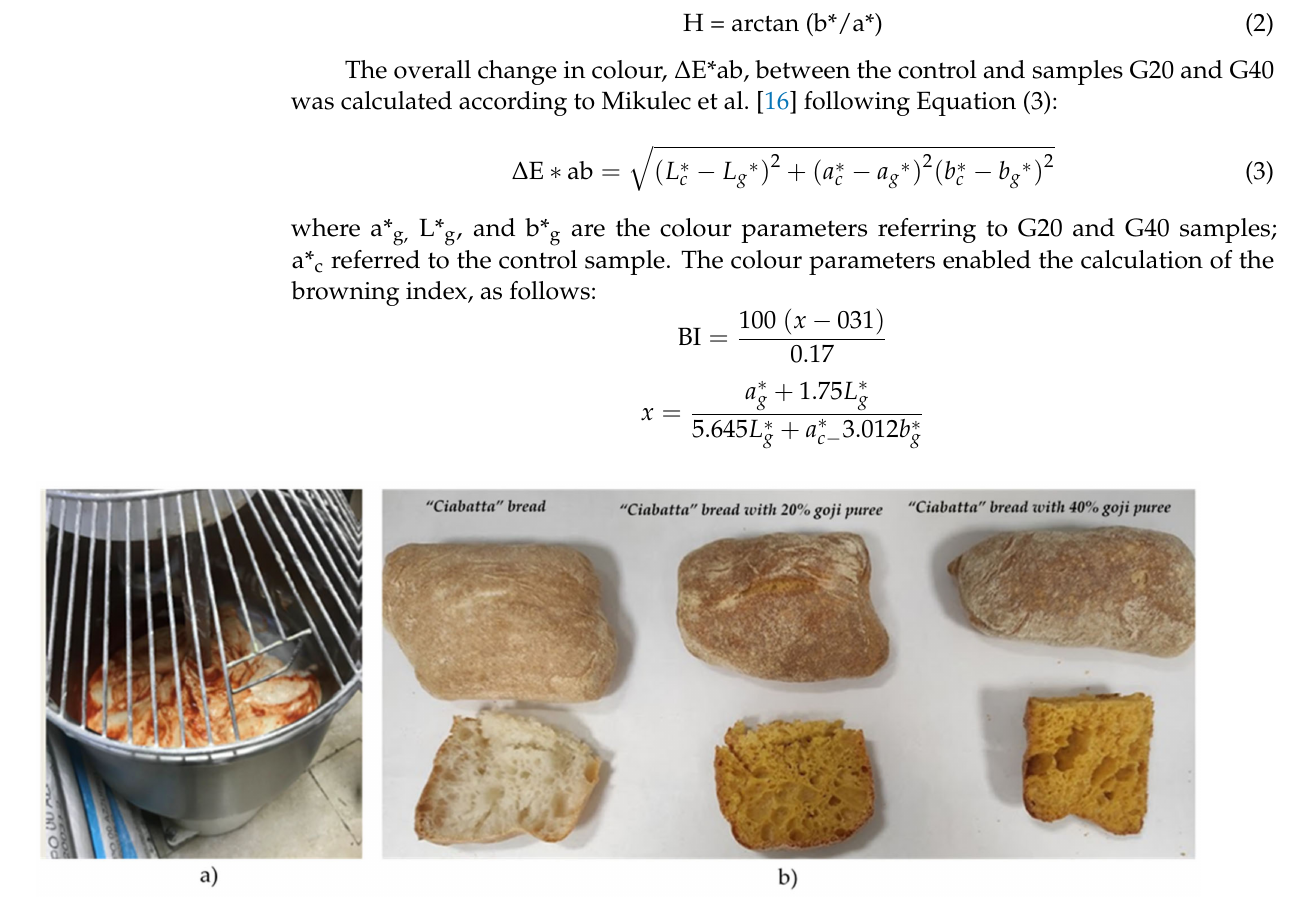
Figure 1. ( a ) Addition of goji fresh flesh puree to dough ( b ) from left to right ciabatta bread and enriched ciabatta bread (with 20% and 40% goji